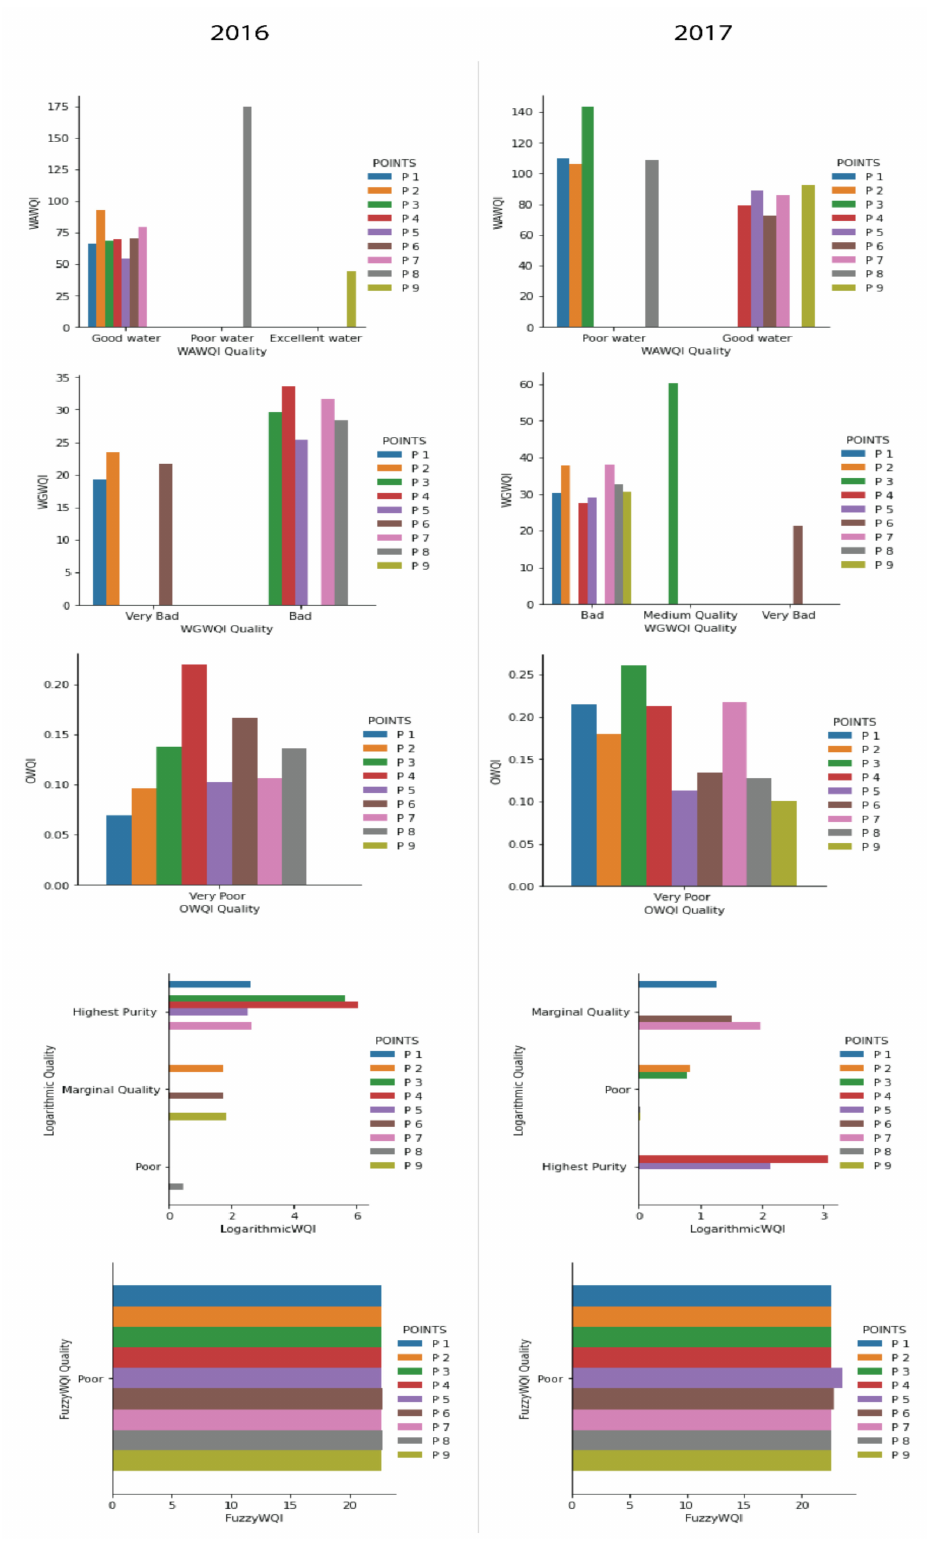
Figure 8. Results of FLWQI in Bar